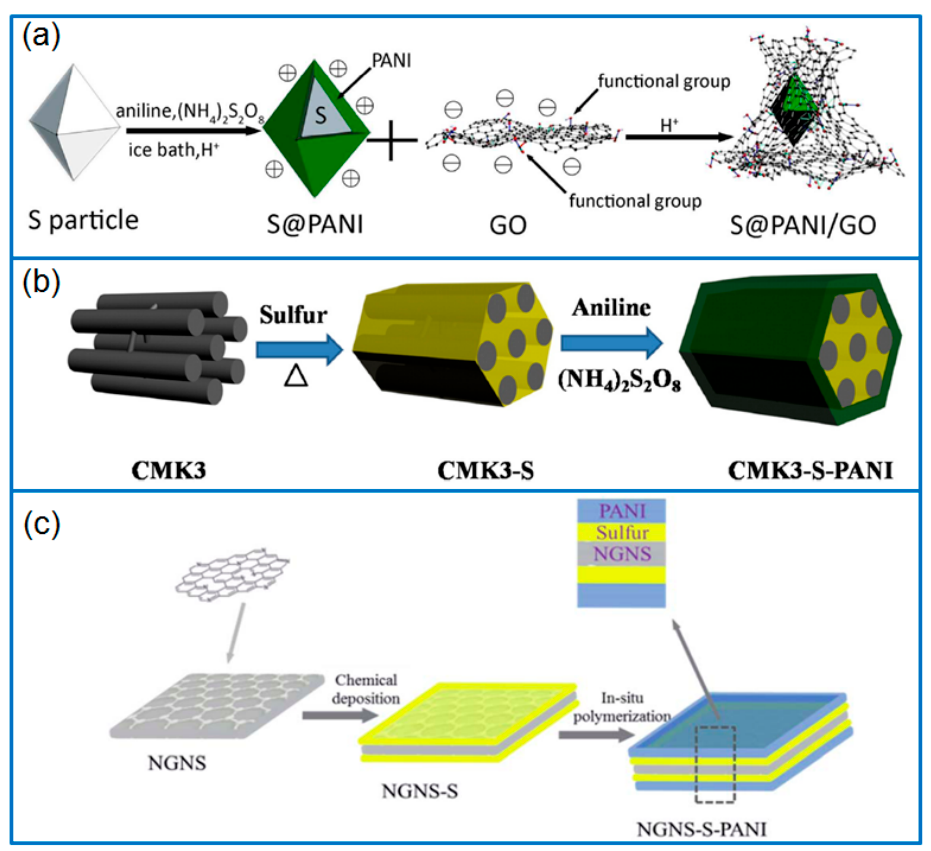
Figure 1. ( a ) The preparation process of S@PANI/GO [19]; ( b ) The wrapping process of CMK3/S-PANI composite [23]; ( c ) Preparation of NGNS-S-PANI [24].